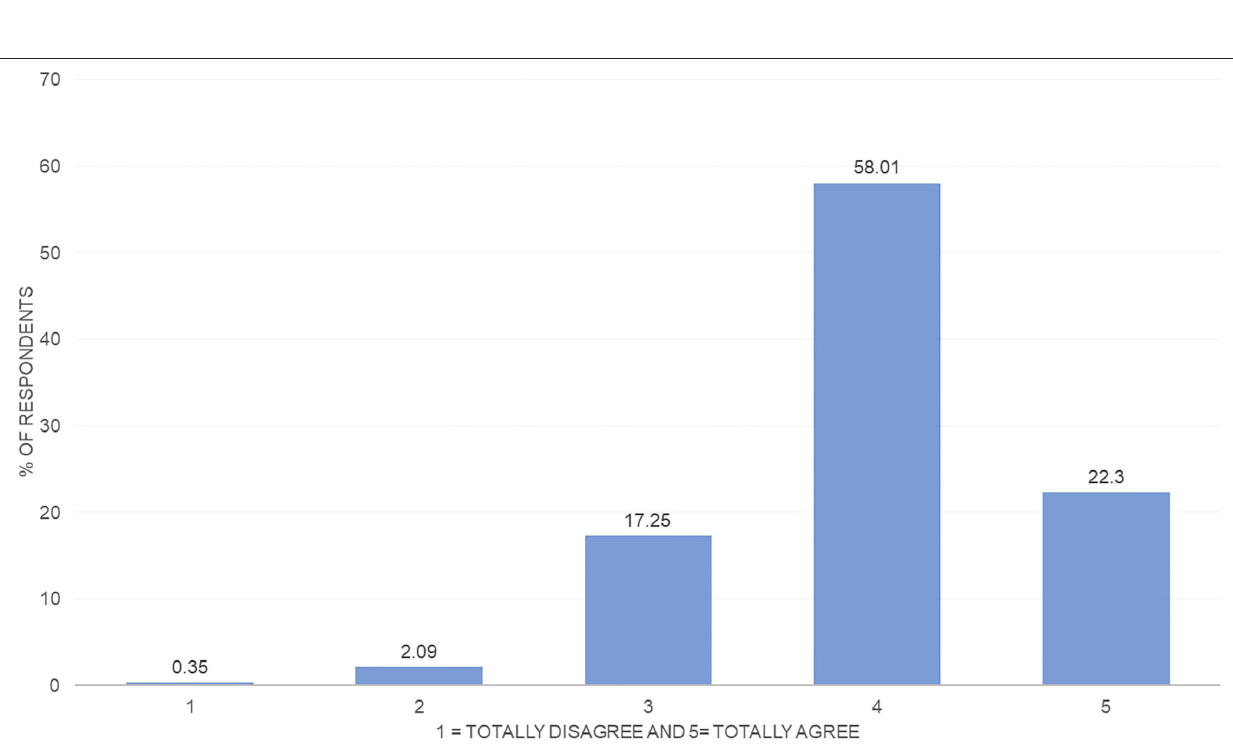
Frontiers in Psychology |